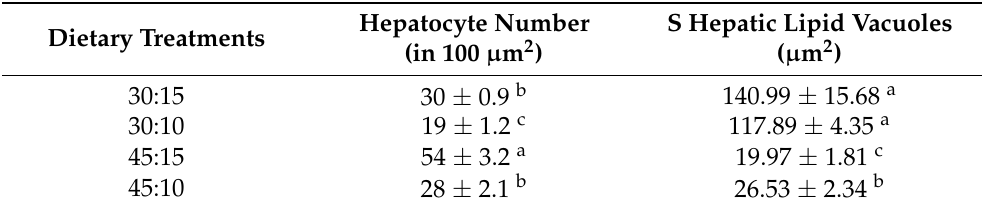
Table 7. Hepatocyte number in the hepatic parenchyma and surface (S) of lipid vacuoles within hepatocytes of P. punctifer specimens (26 dpf) fed diets containing different protein:lipid levels (30:15,